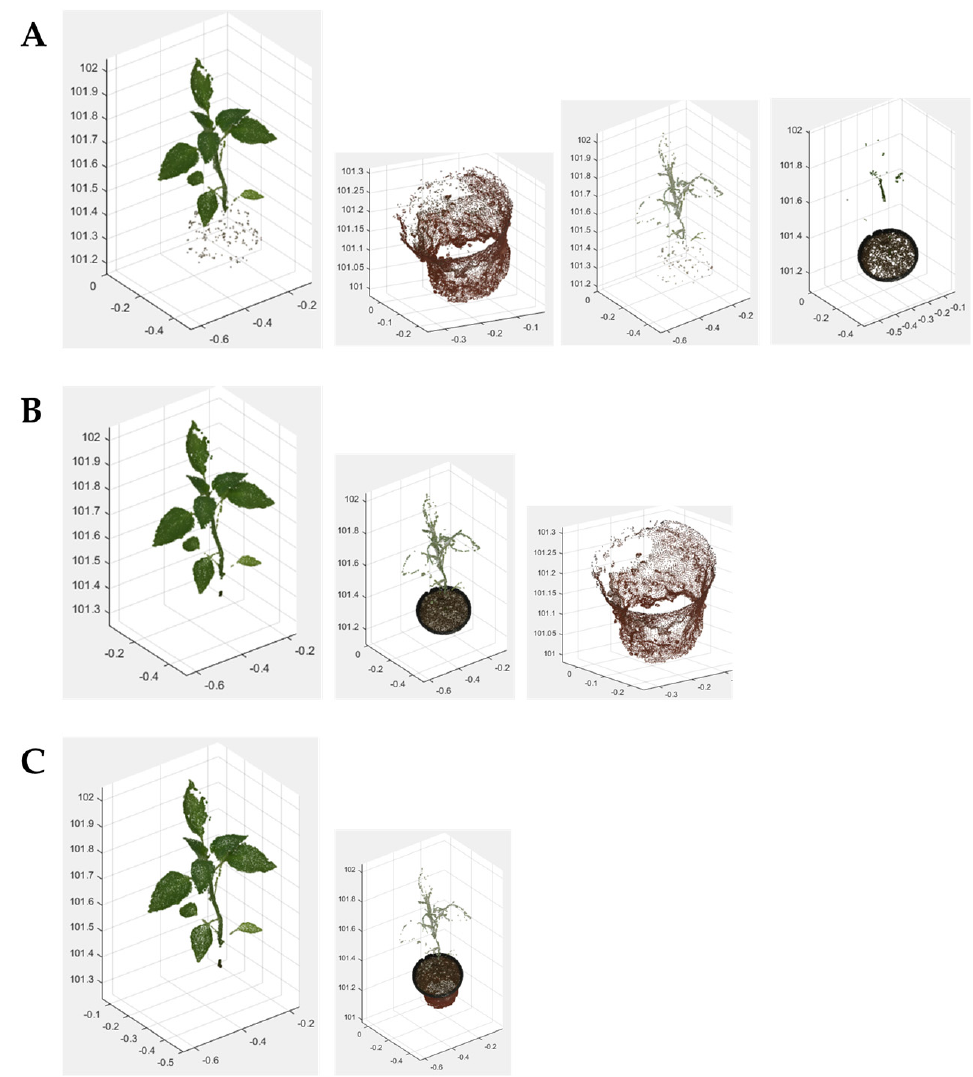
Figure 9. 3D crop extraction result through combination of several algorithms: ( A ) k-means clustering (k = 4); ( B ) ExG + k-means clustering; and ( C ) ExG + Otsu’s threshold. A coordinate system matching process was performed through coordinate transforma- tion of a 3D image of a crop extracted using a combination of algorithms. Figure 10B shows the results of applying the PCA algorithm to the extracted 3D crop image. Components (pc 1 , pc 2 , . . . , pc n ) acquired through the PCA sequentially acquire vertical elements on the basis of the first component. On the basis of pc1 (red line), it can be seen that the vertical components are displayed as blue and green lines. Since the pepper used in the experiment is a height-growing crop, pc 1 was found to coincide with the stem direction. Accordingly, Euler Angle Transformation was performed by considering pc1 to be the axis of the crop. Coordinate transformation was performed using pc1 acquired through PCA as the z-axis of the common coordinate system (Figure 10C). The converted image has the bottom of the crop stem as the origin. Through this, the height of the crop can be easily measured, and the degree and direction of differentiation of leaves from the stem can be measured. It also makes it easier to implement segmentation and automatic measurement algorithms.